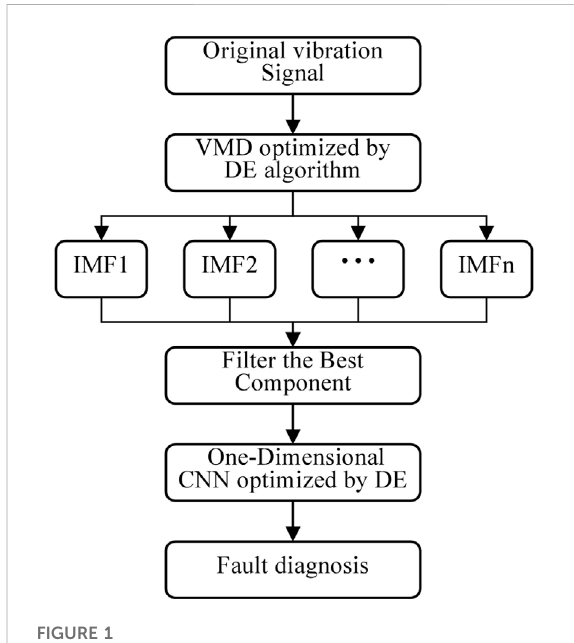
FIGURE 1 The algorithm fl ow of fault diagnosis.